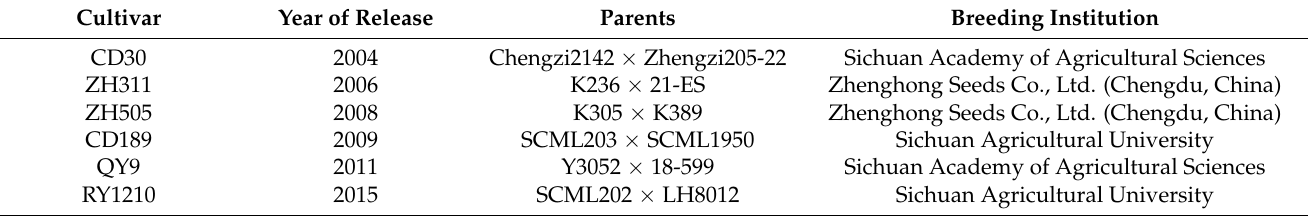
Table 1. Characteristics of cultivars used in this